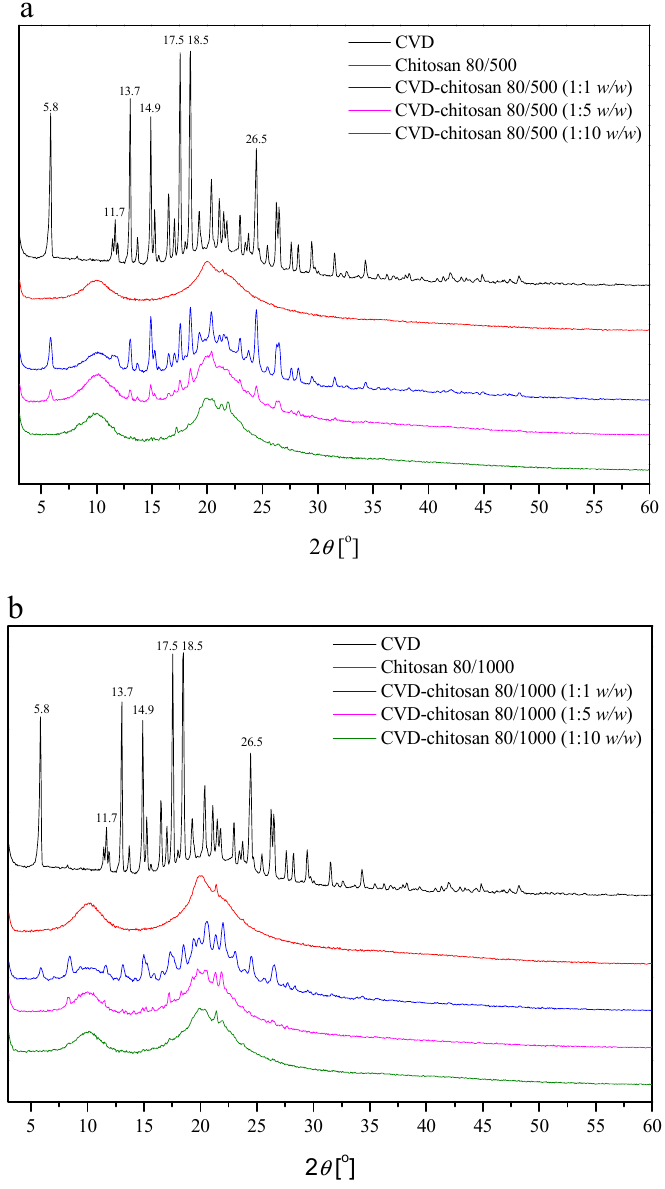
Figure 1. Powder X-ray diffractograms of the solid samples with chitosan 80/500 ( a ) and chitosan 80/1000 ( b ) 2 θ positions of the principal diffraction peaks are shown for CVD.